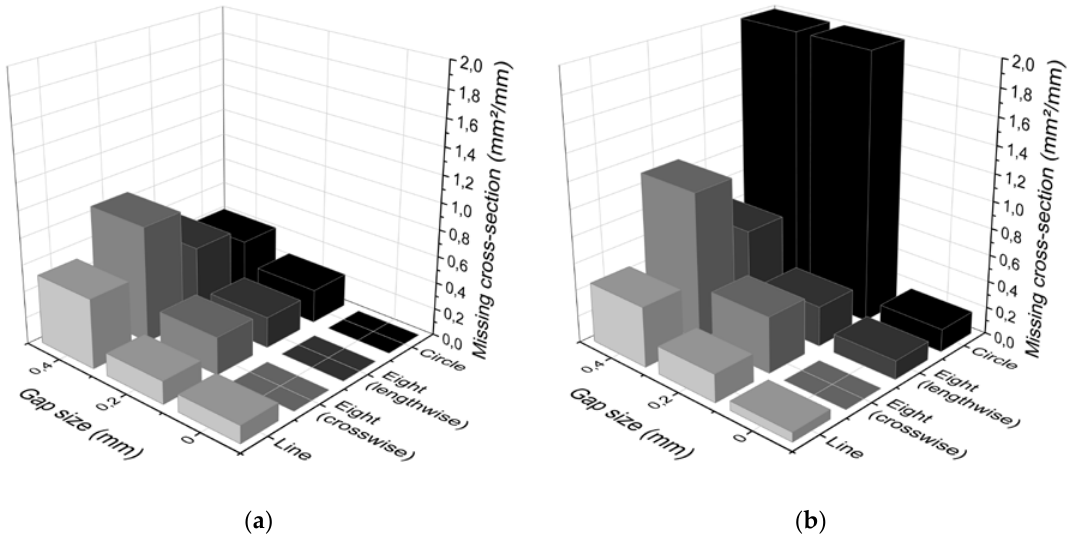
Figure 11. Missing cross-section per mm weld seam length depending on welding speed and gap size for welding at atmospheric pressure ( a ) and 10 hPa ( b ).